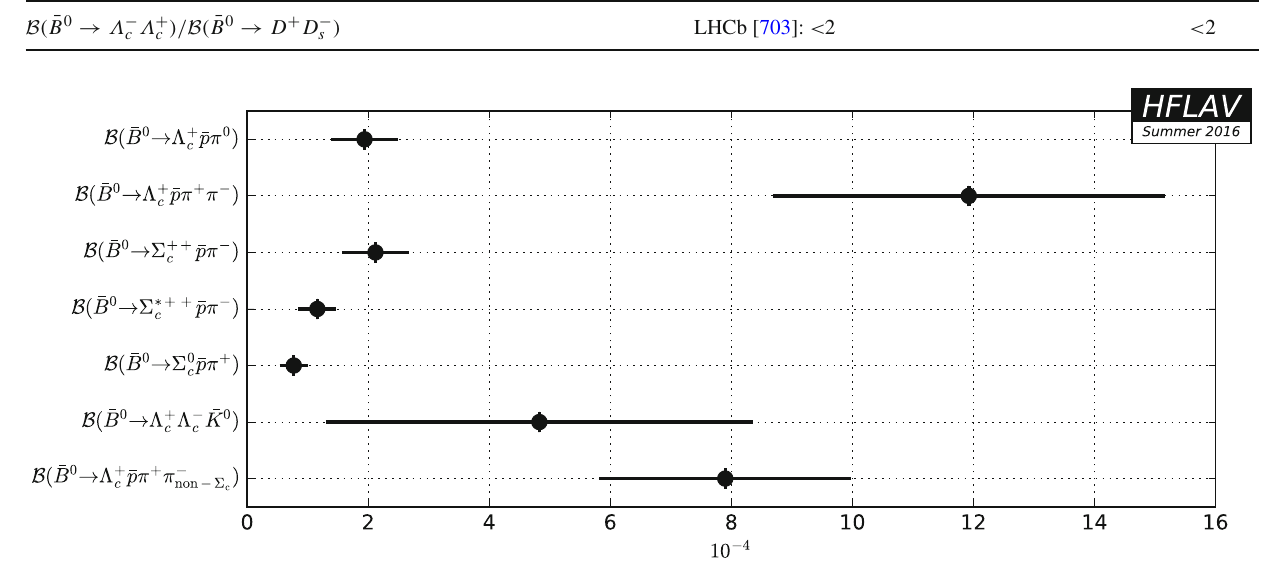
Fig. 99 Summary of the averages from Table